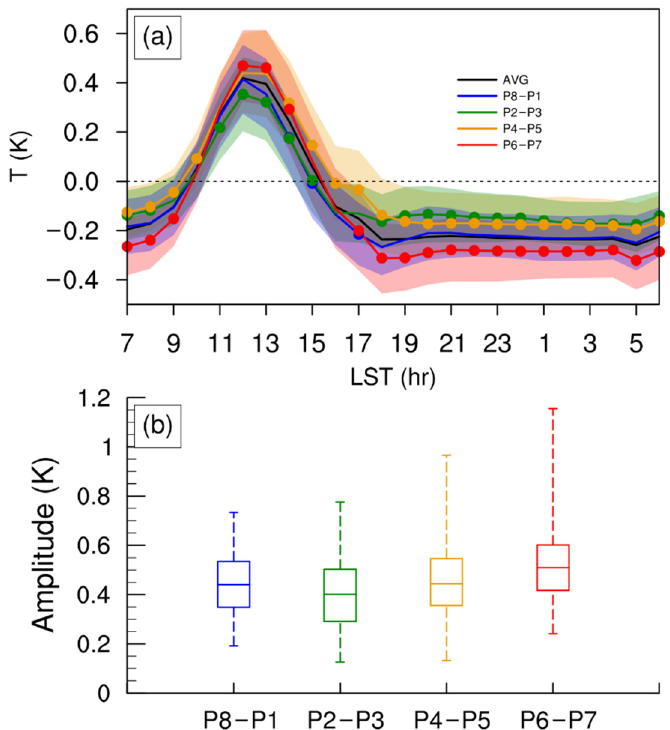
Figure 8. ( a ) The diurnal variations of 850-hPa land–sea temperature contrast (line, K) and its standard deviation (shaded, K) for total average and phase averages, calculated as the landside mean subtracted by seaside mean within 100 km from western Sumatra coast; ( b ) the box figures of diurnal amplitudes (K). The dots in Figure 8a indicate the 95% confidence according to the Student’s t-test.